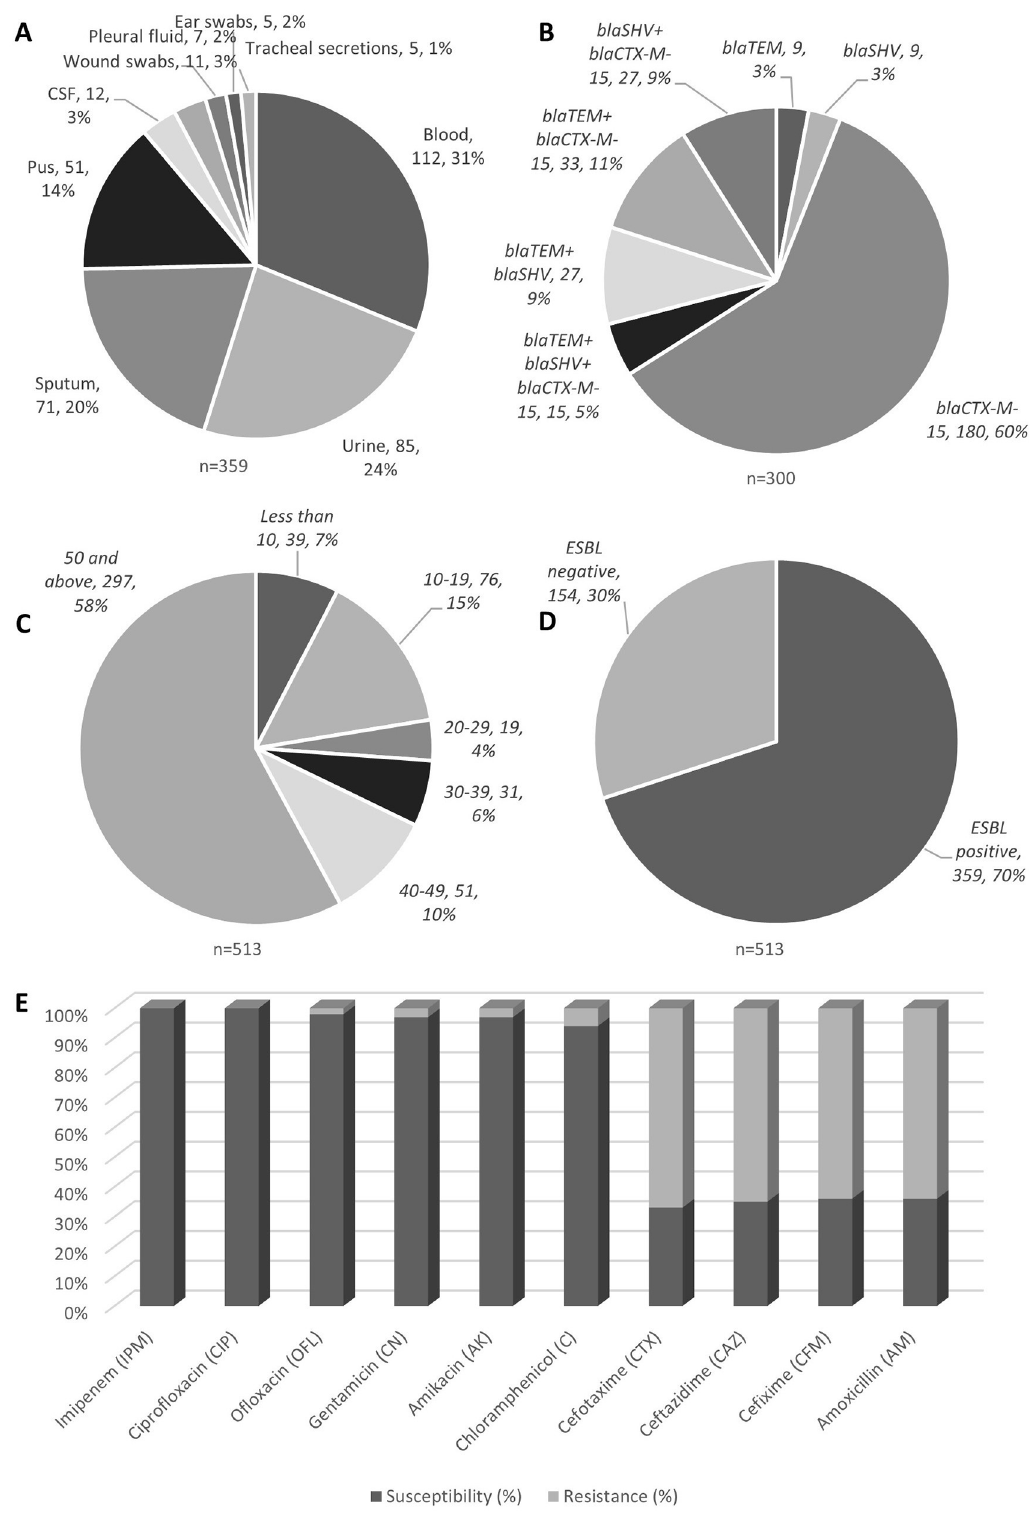
Figure 1. K. pneumoniae isoaltes obtained from various clinical samples showed high prevalence as blood borne infections (A); genotypic distribution showed bla CTX-M-15 to be highly prevalent (B); age group wise analysisshowedelderlygroupof50yearsoldandaboveshowedhighincidences(C);ESBLpositivitiytobe70% among all isolates tested (D), with their antibiotic susceptibility profile (E).